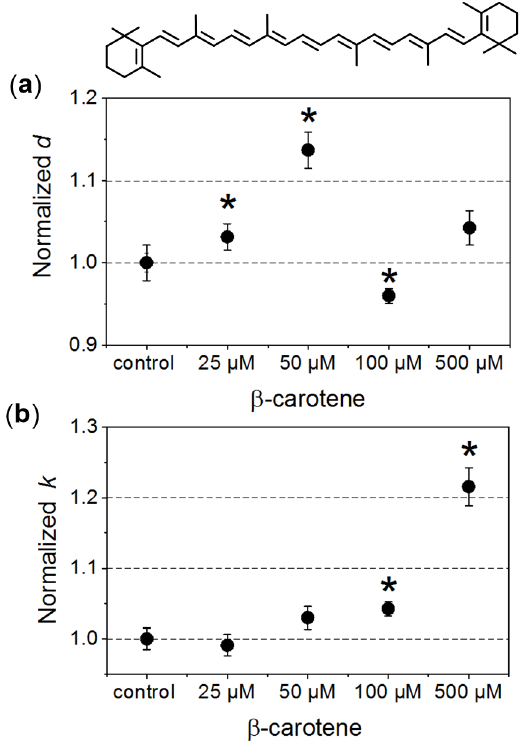
Figure 1. Morphometric changes of red blood cells (RBCs) treated with different β -carotene ( β -Crt) concentrations: ( a ) normalised values of diameter, d , and ( b ) longitudinal to lateral ratios, k . One hundred RBCs per randomly selected donor were analysed. In each case, the mean values of d and k parameters obtained for three randomly selected donors are shown. The presented errors of the values are calculated from the square of mean standard deviation of the mean average. The statistically significant differences for individual sets of samples (RBC β -Crt –RBC control ), as revealed by the p -values ( p < 0.05) of the Wilcoxon test are marked with an asterisk (*). Top: β -Crt chemical structure. The increase in the mean diameter of RBCs is already observed at a concentration of 25 µ mol/L β -Crt, and the parameter d reaches its maximum at 50 µ mol/L (it is about 15% larger in the case of treated RBCs when compared to control samples). RBCs incubated